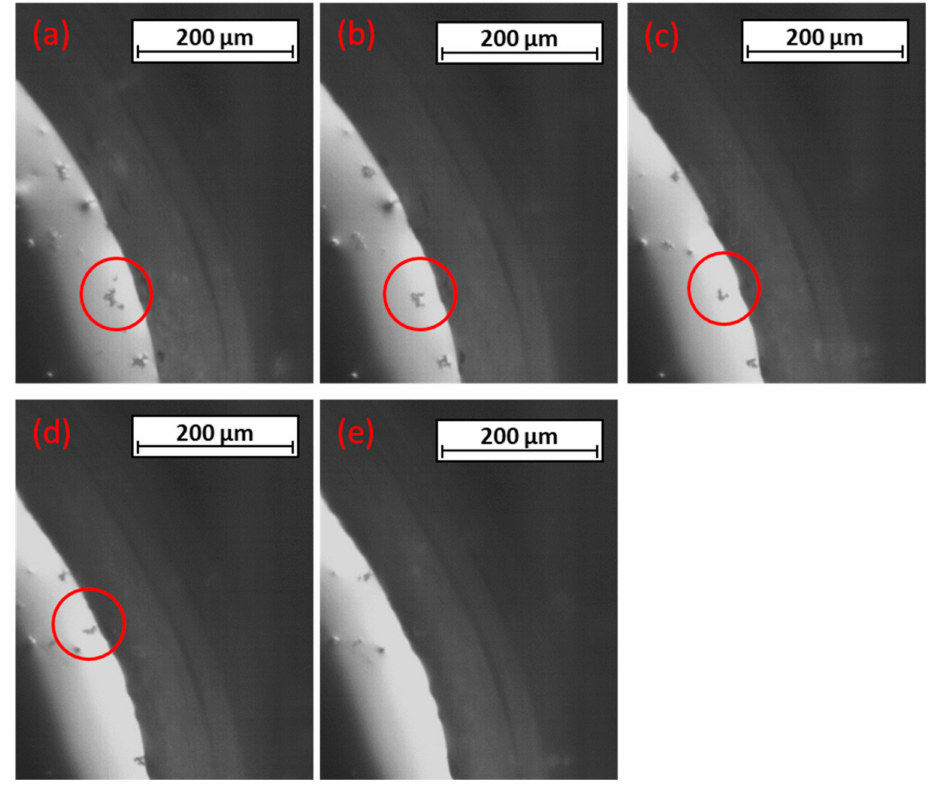
Figure 7. ( a – e ) Movement, agglomeration, and dissolution of the non-metallic